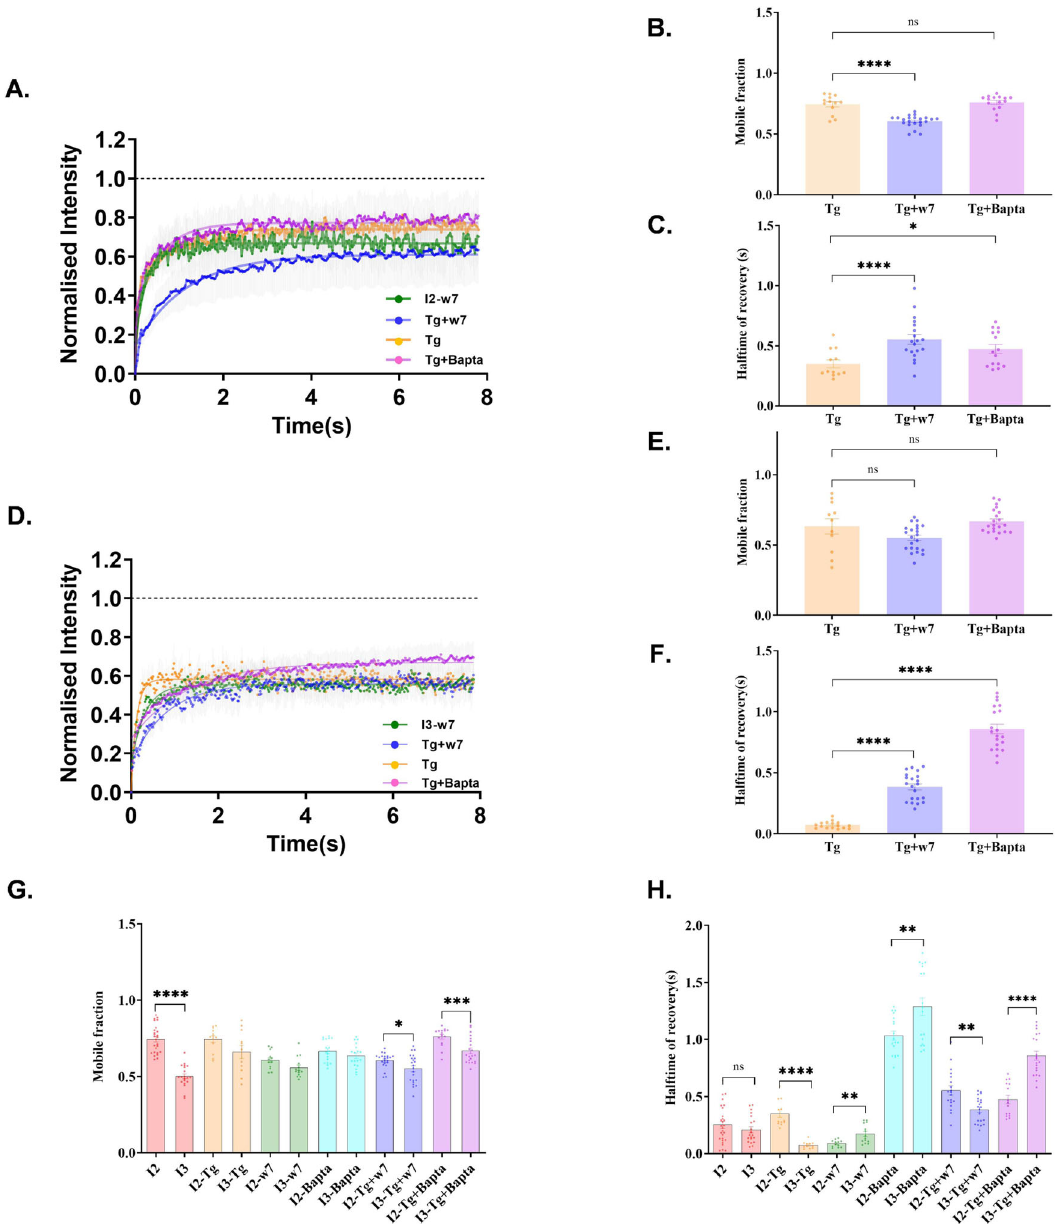
Fig. 5 Effect of Calmodulin and cytosolic Ca 2 + levels on hDLG::GFP variants. The recovery of fl uorescence intensity in cells expressing I 2 -hDLG::GFP ( A ) and I 3 -hDLG::GFP ( D ) treated with w7, Tg, w7 + Tg, and Tg + Bapta fi t by a single-phase exponential growth curve. N = 8 cells; ROI = 13 (Tg), 10 cells; ROI = 22 (Tg + w7), 9 cells; ROI = 15. The data is cumulated from three experiments. The data was statistically tested using a two-tailed unpaired t -test with Welch ’ s correction. * p < 0.05, ** p < 0.01, **** p < 0.0001 (Supplementary Table 4). The mobile fraction and halftime of recovery of I 2 ( B , C ) and I 3 ( E , F ) were extracted from the analysis of the respective curves. Mobile fraction ( G ) and halftime of recovery ( H ) of all conditions between I 2 -hDLG::GFP and I 3 -hDLG::GFP expressing cells were analyzed using a two-tailed unpaired t -test with Welch ’ s correction. Data are presented as mean values ± SEM. * p < 0.05, ** p < 0.01, **** p < 0.0001 (Supplementary Tables 4 and 5). Source data are provided as Source Data fi by Ca 2 + inhibition, I 3 was found to be signi fi cantly con fi ned with respect to I 2 ( I 2 − Tg + Bapta = 0.76 ± 0.01; I 3 − Tg + Bapta = 0.67 ± 0.02) (Fig. 5G). The halftime of recovery showed no signi fi cant isoform-speci fi c difference in untreated condition ( I 2 = 0.25 ± 0.03; I 3 = 0.21 ± 0.03), while with Tg incubation, I 3 showed faster kinetics with respect to I 2 ( I 2 − Tg = 0.35 ± 0.03; I 3 − Tg = 0.07 ± 0.01).